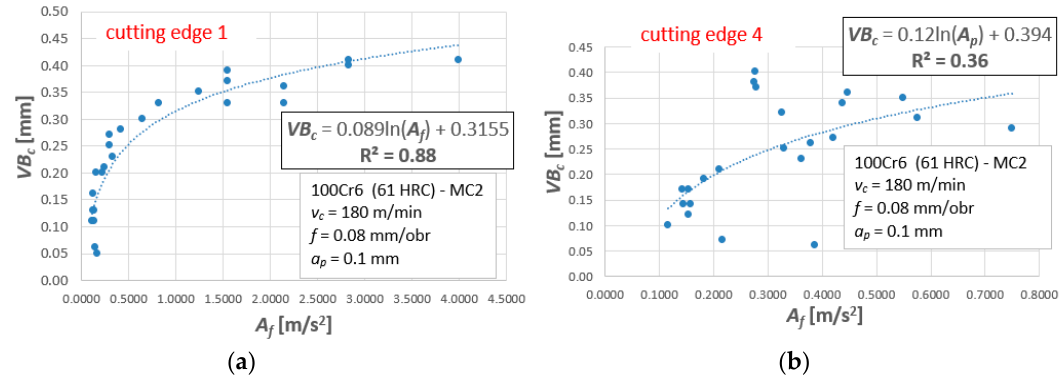
Figure 10. Exemplary one-variable regression model for Af: ( a ) tool corner No. 1 and ( b ) tool corner No. 4.